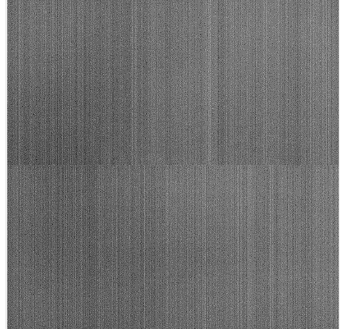
Figure 2. Images taken by CIS with fixed pattern noise (FPN) noise (including two-ended output structure).